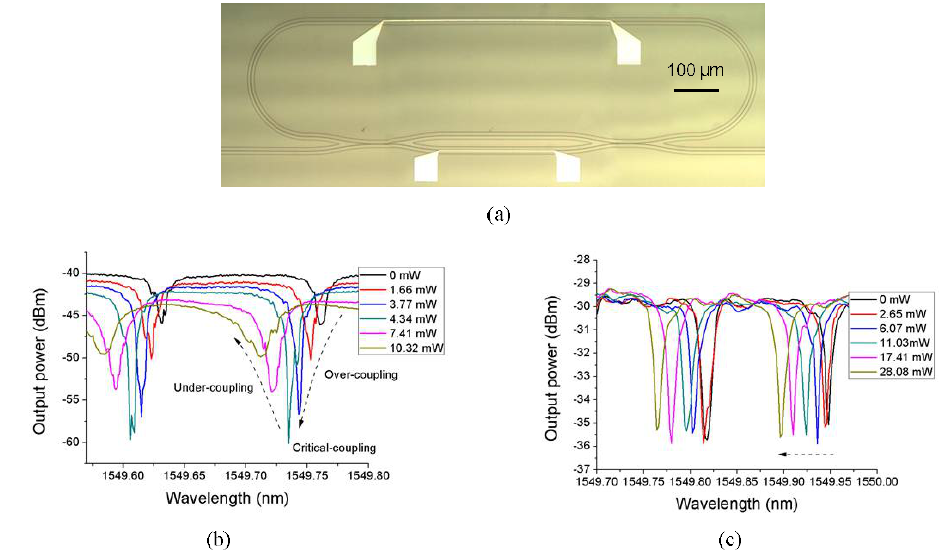
Figure 15. Schematic structures of the microring resonators consisting of ( a ) a directional coupler and ( b ) a MZI based tunable coupler.